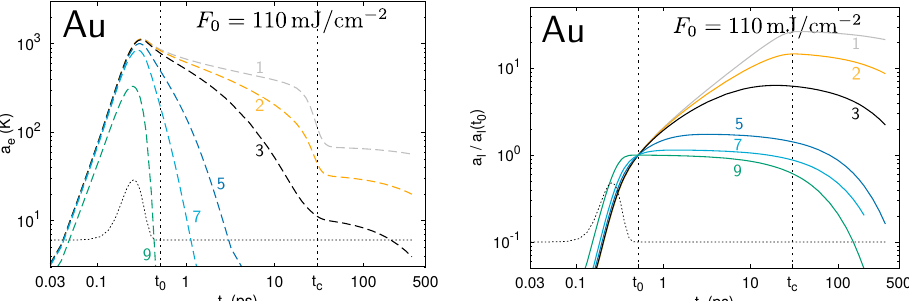
Figure 3. Schematics of the feedback loop responsible for amplification of the lattice temperature modulation during the electron–lattice coupling stage. See text for the details.